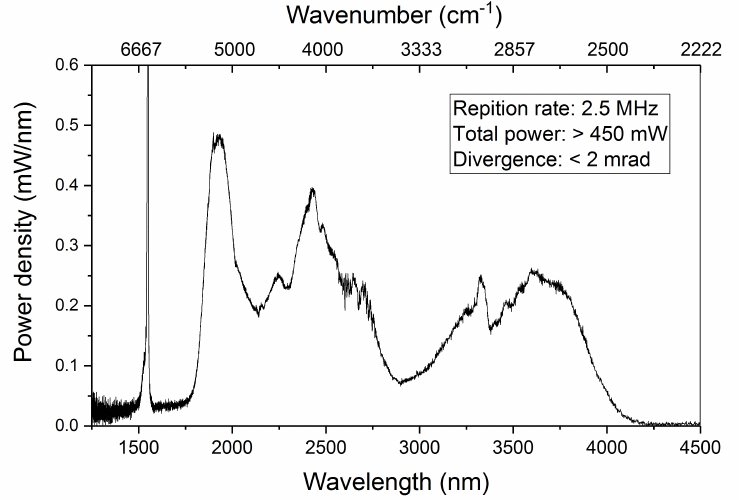
Figure 1. Spectral power density of the SC light source integrated into the gas